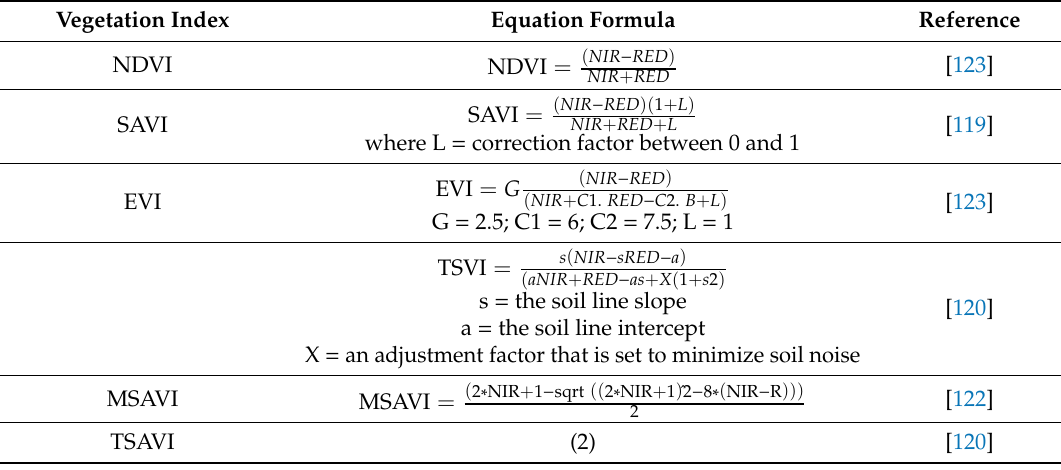
Table 2. Summary of vegetation